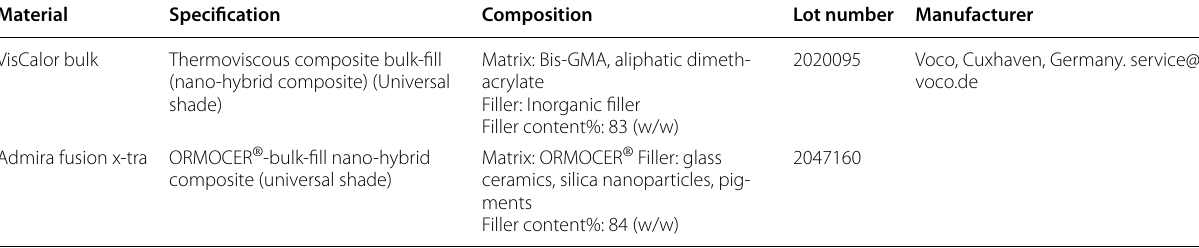
Table 1 Materials used, specification, composition, lot number and manufacturer Material